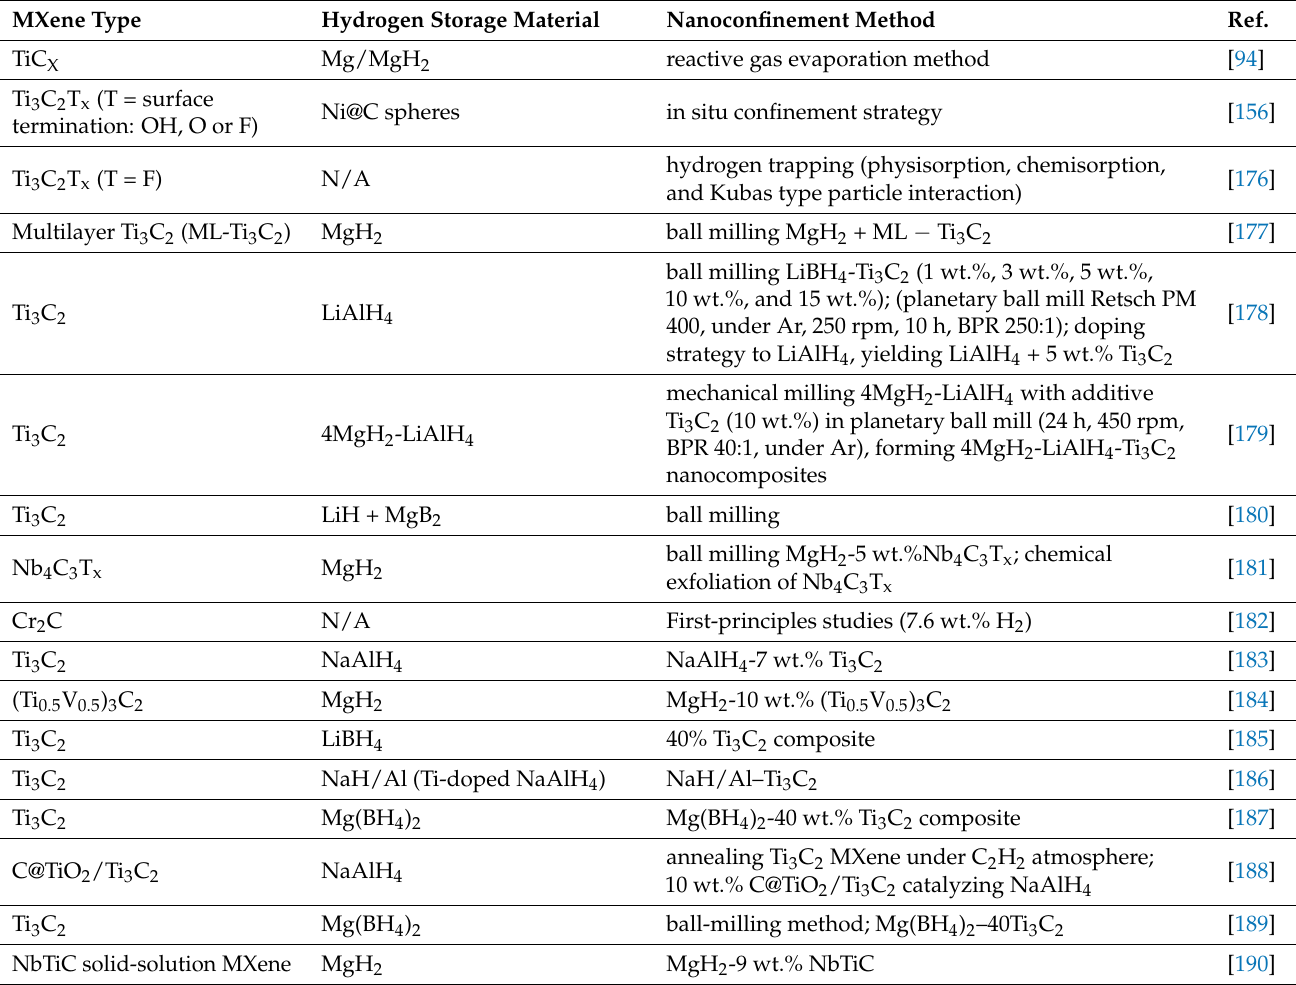
Table 7. Examples of MXenes used as hosts for hydrogen storage